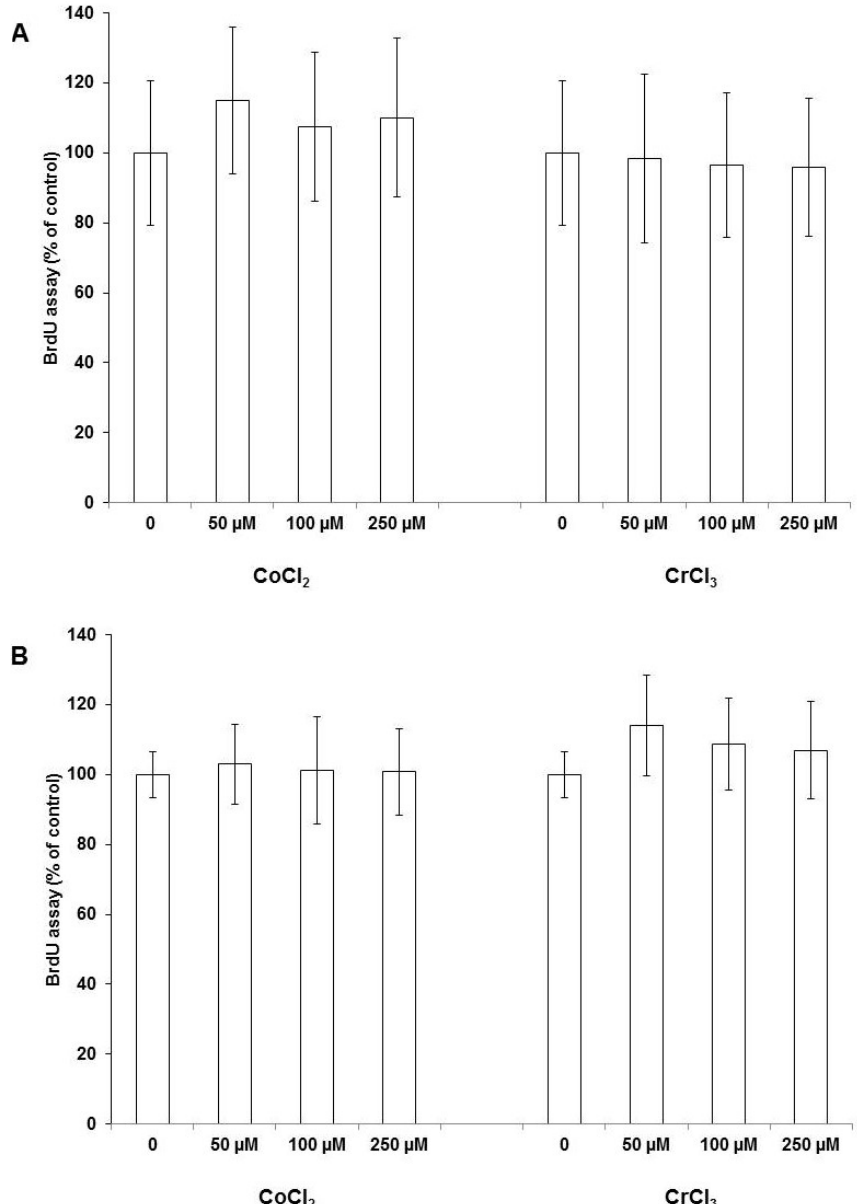
Figure 1. Proliferation activity of MG63 ( A ) and SaOs-2 ( B ) cells after 48 h stimulation with CoCl 2 and CrCl 3 . Data represent the mean and standard deviation of four independent experiments, each performed in triplicate.